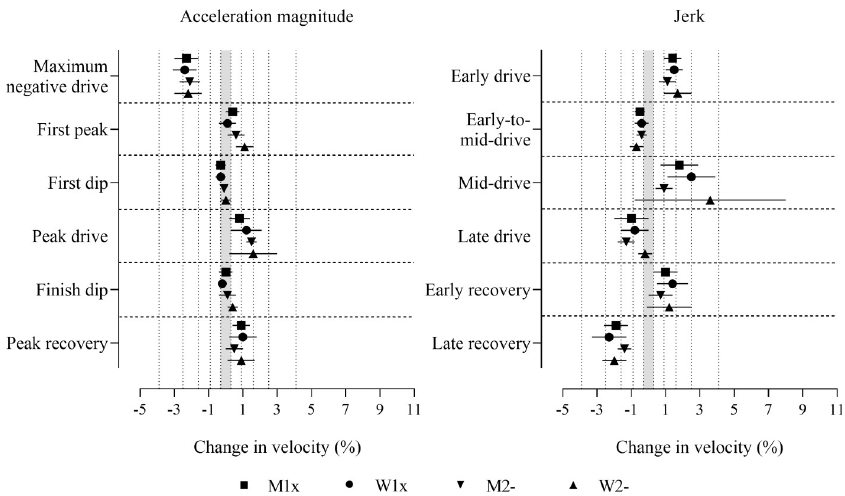
Fig 3. Change in boat velocity for a change in each predictor variable of two within-crew standard deviations without adjustment for stroke rate or power output. Data are mean (%) and 90% compatibility intervals. The shaded grey area covers trivial values (values within the smallest substantial change thresholds, -0.3 to 0.3%). Vertical dotted lines delineate threshold magnitudes of small ( ± 0.3), moderate ( ± 0.9), large ( ± 1.6), very large ( ± 2.5), and extremely large (4.1, -3.9%). Effects with compatibility intervals that do not enter the grey area are decisively (very likely or most likely) substantial. Effects with compatibility intervals that end within the grey area have adequate precision (possibly or likely substantial or trivial).